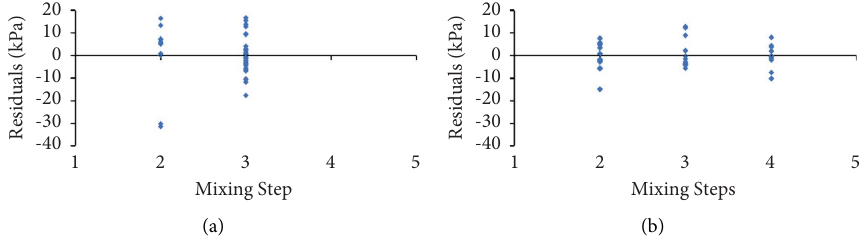
Figure 12: Residual values of the UCS results of (a) 7% Multicem and (b) 5%